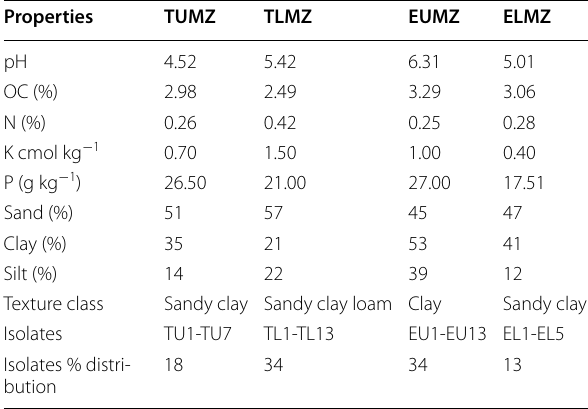
Table 1 Soil properties from the experimental